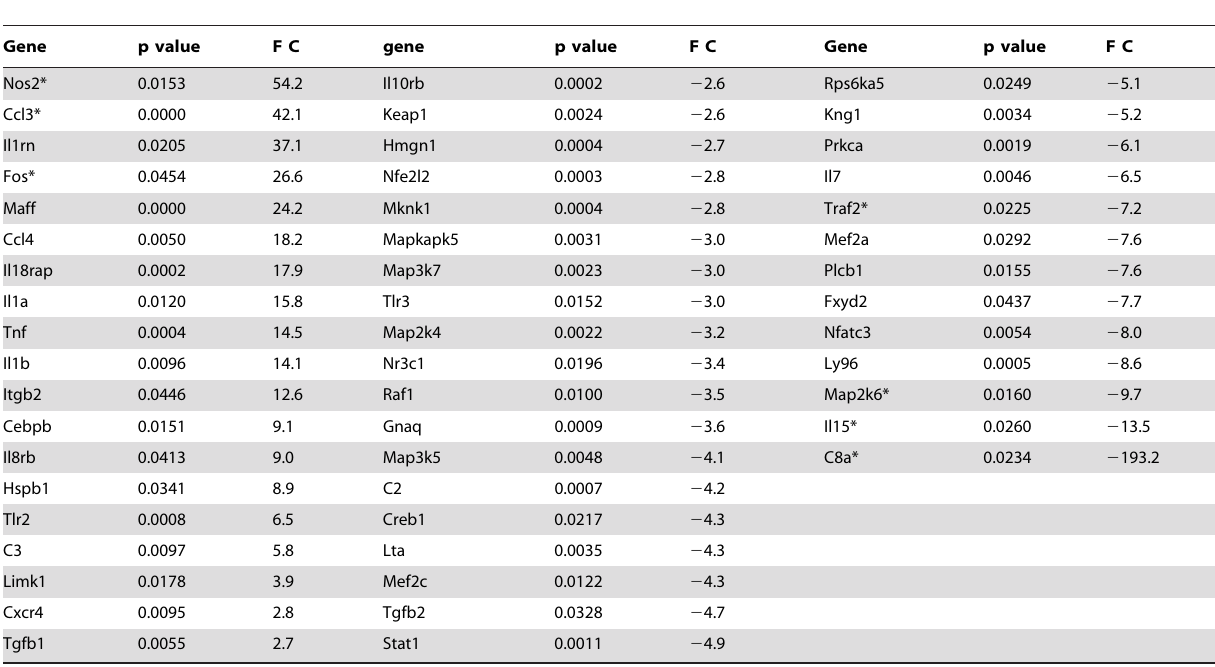
Table 1. Inflammatory gene expression in infected mouse kidneys by NanoString